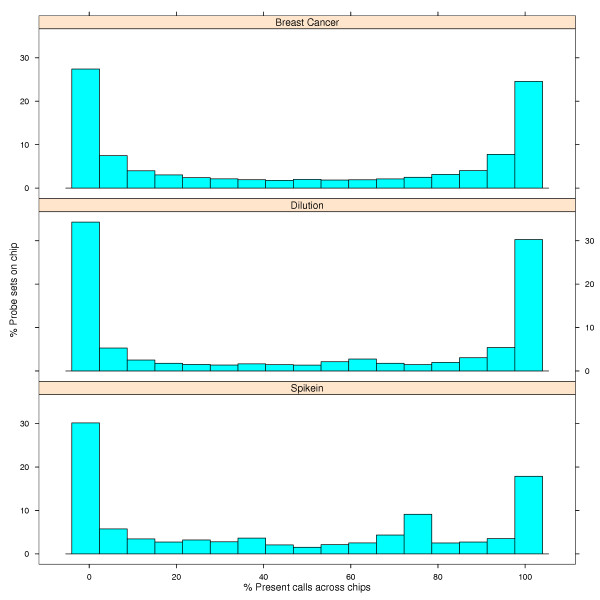
Percentage of Affymetrix present calls across all chips for all three data sets. For each probe set, the percentage of present calls across all chips in its data set was calculated. The histograms show the frequencies of these percentages. For each data set, about 30% of all probes are absent on all chips, and between 20 and 30% are present on all chips, with the balance equally distributed between the extremes.